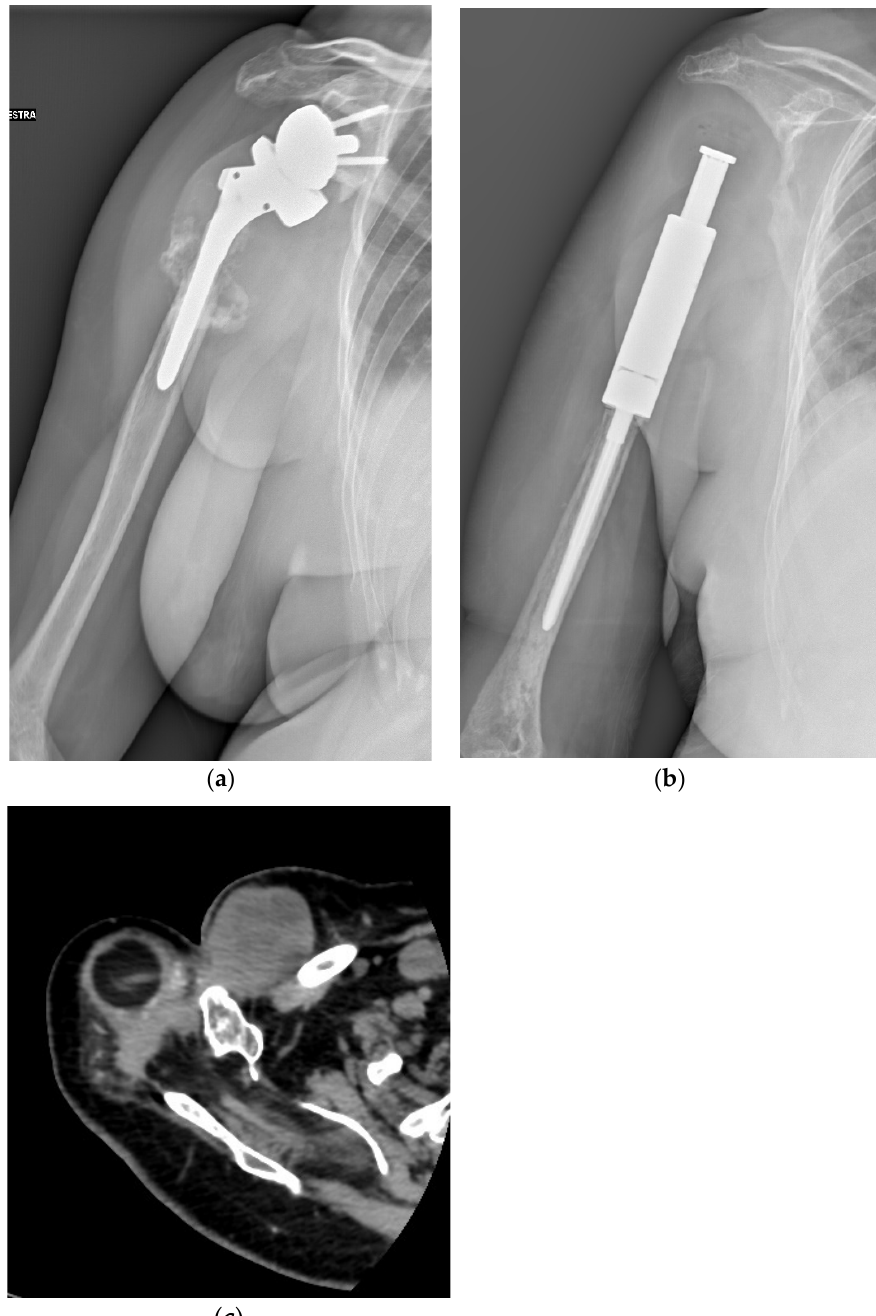
Figure 3. A 71-year-old female patient underwent en bloc resection and reconstruction with a prosthesis for a bone giant cell tumor of the proximal humerus with a pathological fracture at presentation. Six months postoperatively, she experienced local recurrence and was treated with denosumab for 2 years and 5 months ( a ). She then underwent tumor resection and revision of prosthesis ( b ). One year after the revision, she experienced local re-recurrence and underwent tumor resection. One month later, a third local recurrence and lung metastasis were detected, and the biopsy revealed malignant transformation ( c ). She died of the disease 6 years and 4 months after the first surgery (Case 26, Tables 3 and 4).